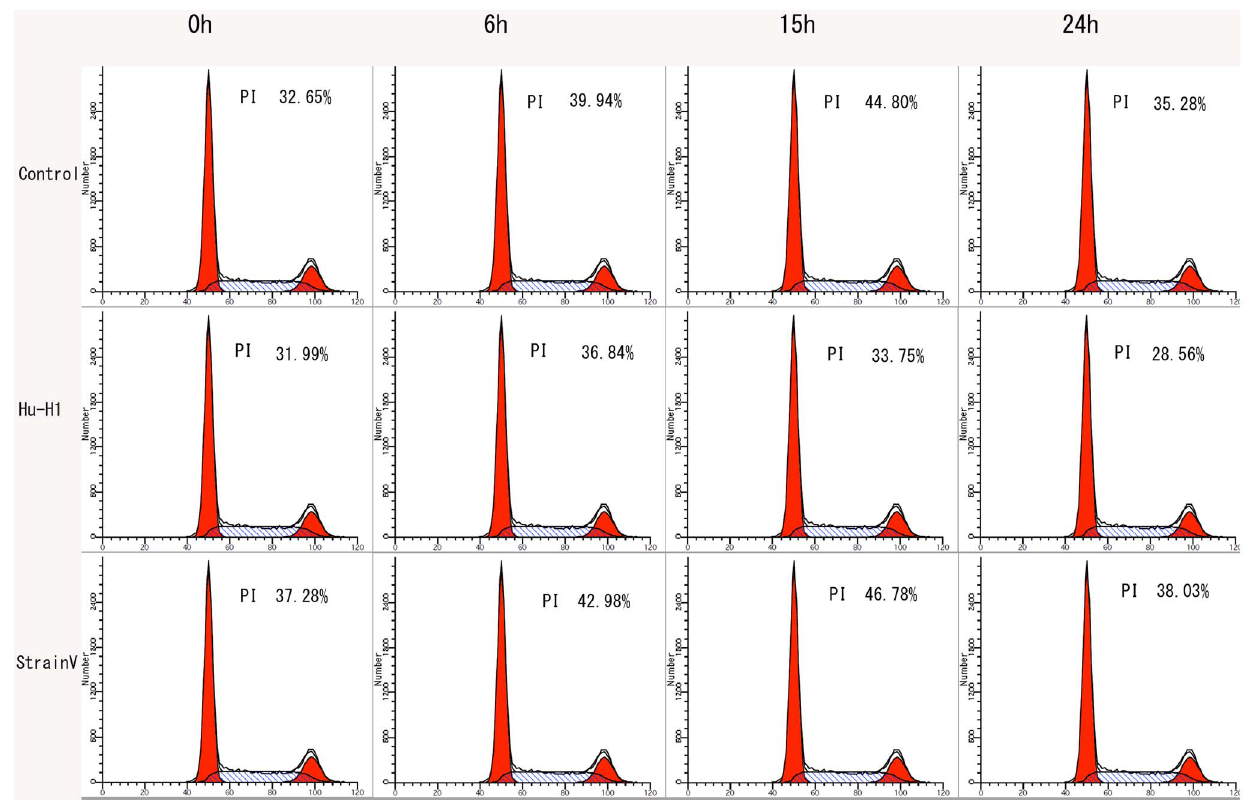
Figure 3. Cell cycle analysis of Hu-H1, Strain V, and control cells.